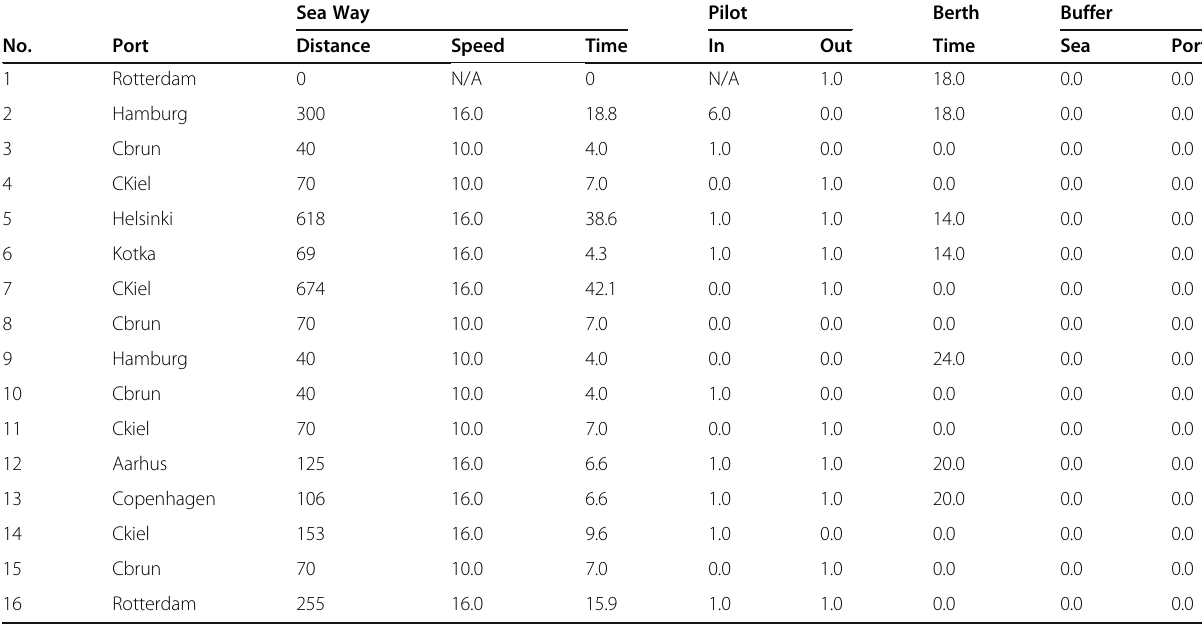
(2) Standardized treatment of indicators. There are usually different dimensions and orders of magnitude among the evaluation indicators and the original indicators need to be standardized. The original value can be transformed into a dimensionless value by the formula below.